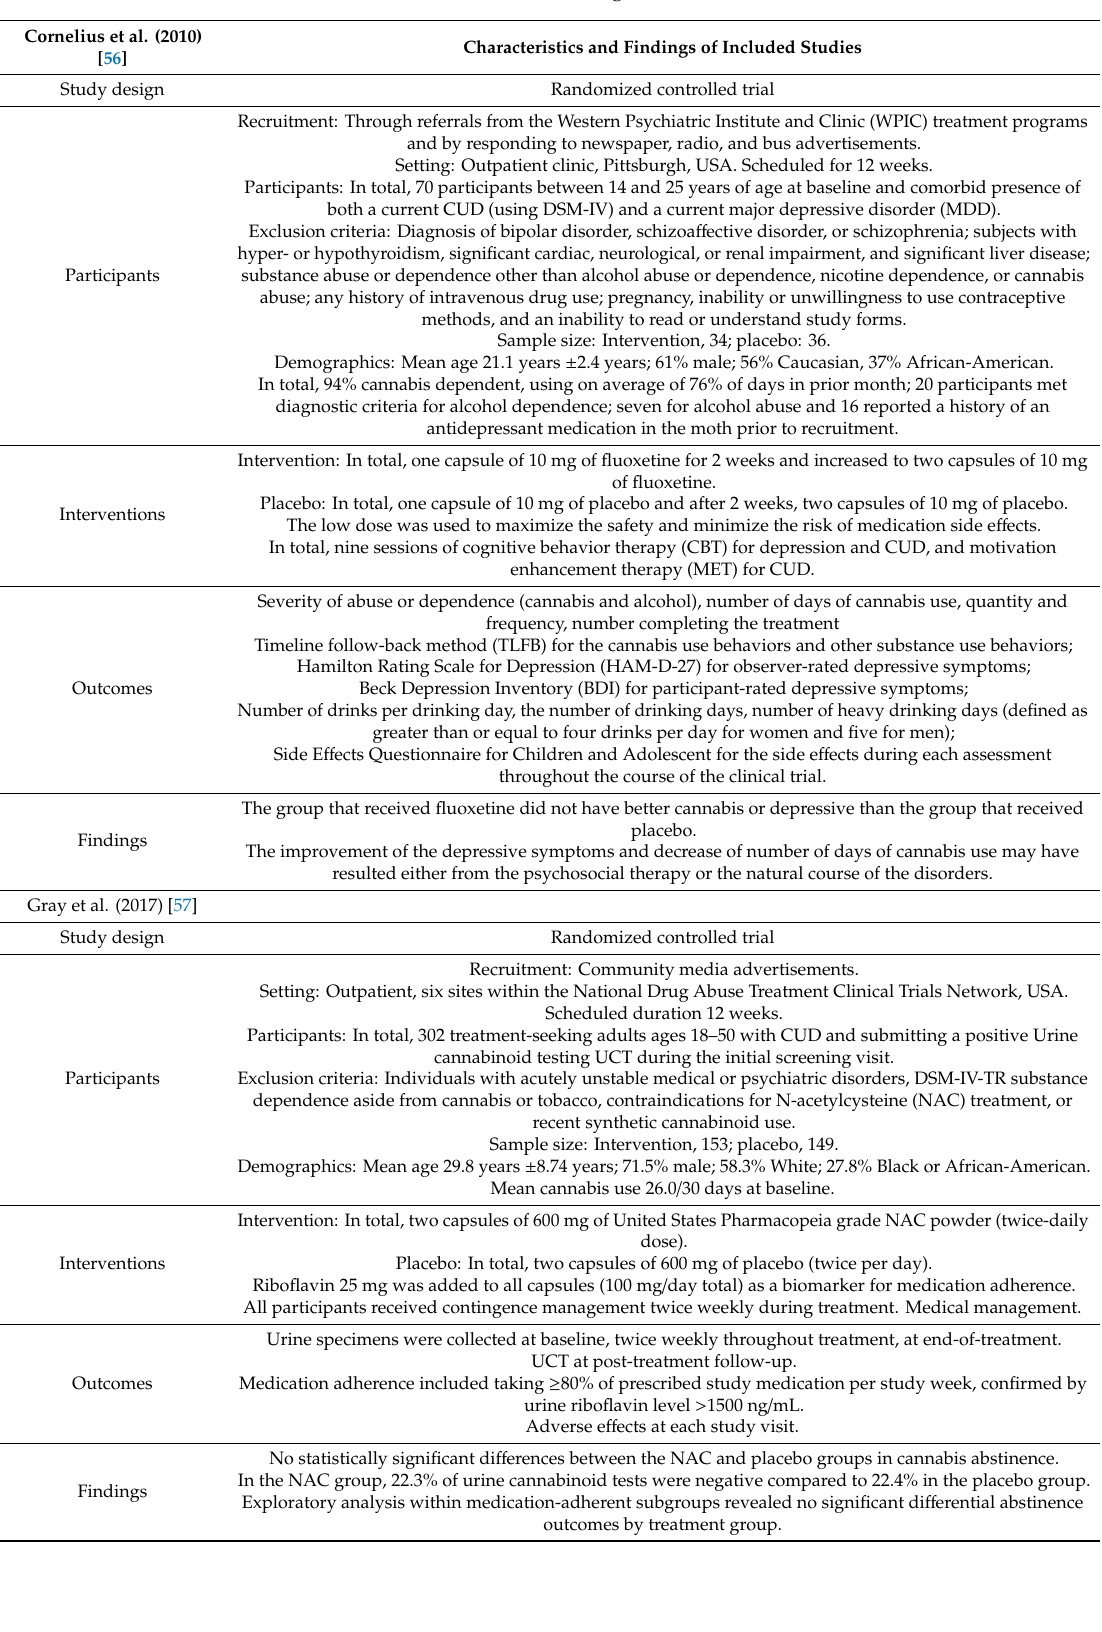
Table 2. Characteristics and findings of included